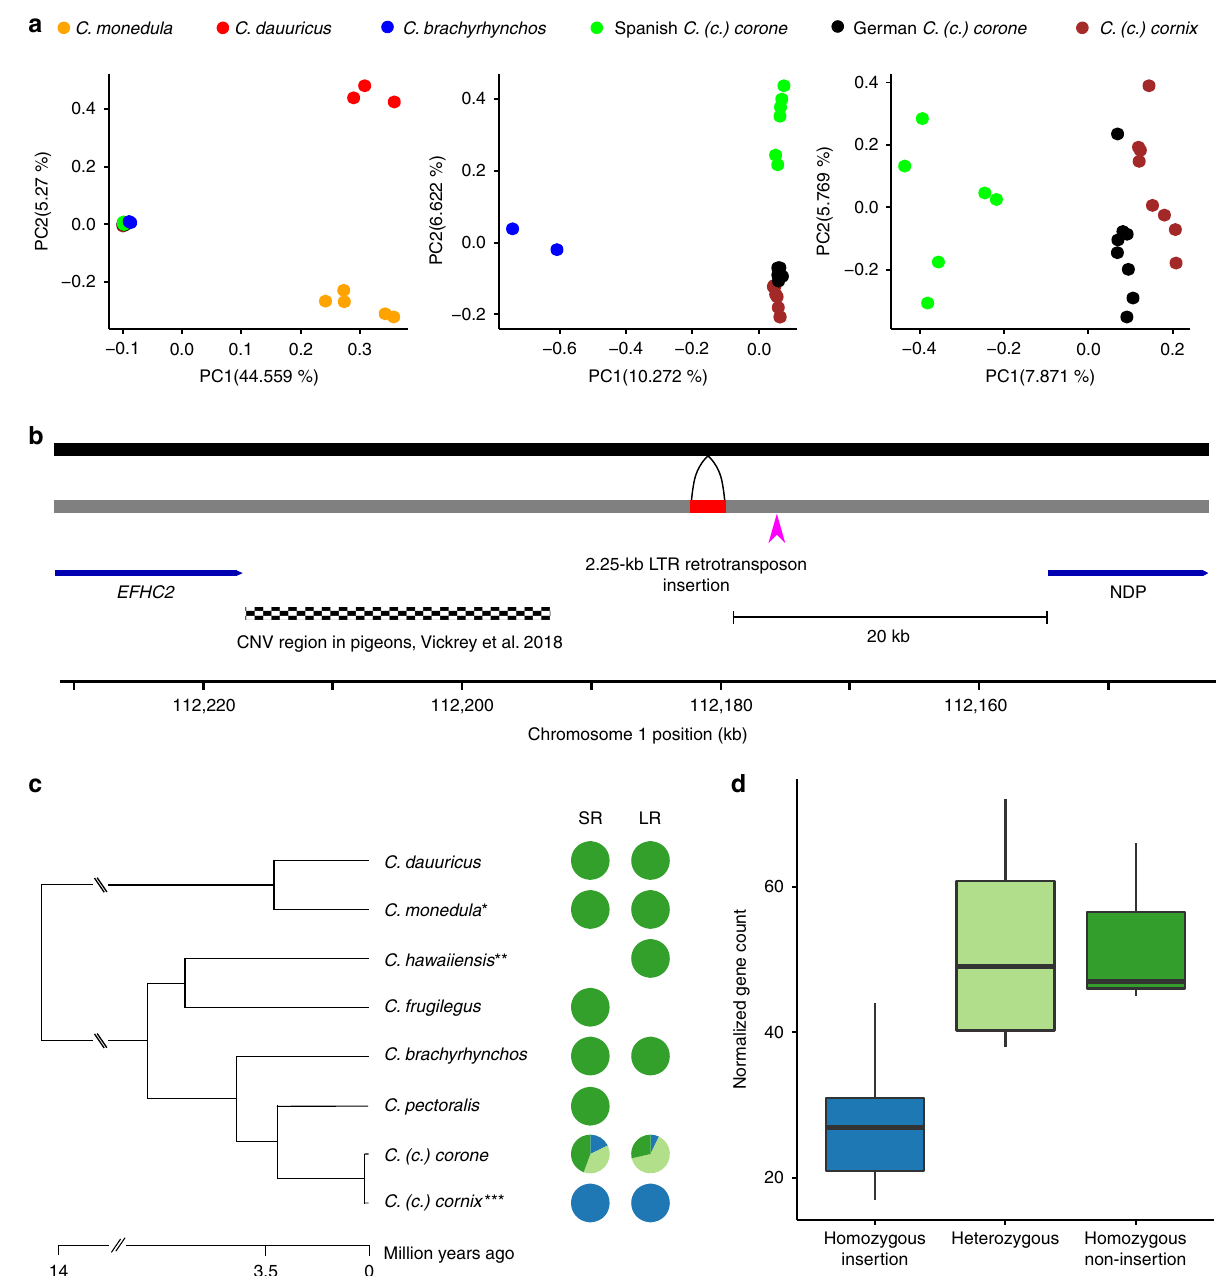
Fig. 4 SV-based population structure and LTR retrotransposon insertion upstream of the NDP gene. a Principal component analysis based on SV genotypes. In the left, all individuals were analyzed together. Individuals of the crow clade are tightly clustered and separate from the jackdaw clade along PC1; individuals of the two jackdaw species separate along PC2. The middle displays the results of PCA conducted exclusively for individuals from the crow clade, clearly separating American crows from the Eurasian species. In the right, only the European populations of the crow clade are included, showing marked separation of the Spanish carrion crow population. b A 2.25-kb LTR retrotransposon insertion into the crow lineage (black bar: ancestral state, gray bar: derived, reference allele) belongs to the endogenous retrovirus K (ERVK) subfamily corCorLTRK1b and is located 20 kb upstream of the NDP gene. A highly conserved non-coding region (pink arrow) is present in close proximity (2.8 kb) to the insertion in the 3 ′ fl anking sequence. This region, which is conserved between chicken, human, and crow (Supplementary Fig. 8), is likely a regulatory element which may be affected by the nearby LTR retrotransposon insertion. Located in the 5 ′ region of the insertion is a region copy number variable in pigeons, associated with plumage pattern variation. c Genotypes of the LTR insertion in short-read (SR) and long-read (LR) data. In both datasets, the LTR element insertion (blue) is fi xed in all hooded crow populations. Species and populations with a black plumage are either polymorphic (light green) or fi xed for the ancestral state, non-insertion (green). d Gene expression of NDP in body skin. Normalized gene counts of 18 individuals are signi fi cantly associated with the insertion genotypes (LMM, p = 0.002), boxplot center lines show median show medians and whiskers 1.5 times the interquartile range ( n = 19). Source data are provided as Source Data fi